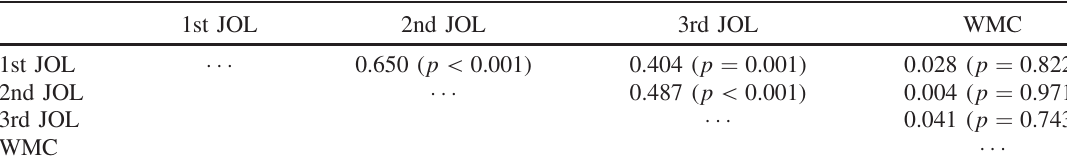
TABLE IV. Correlation matrix for the three JOLs and working memory